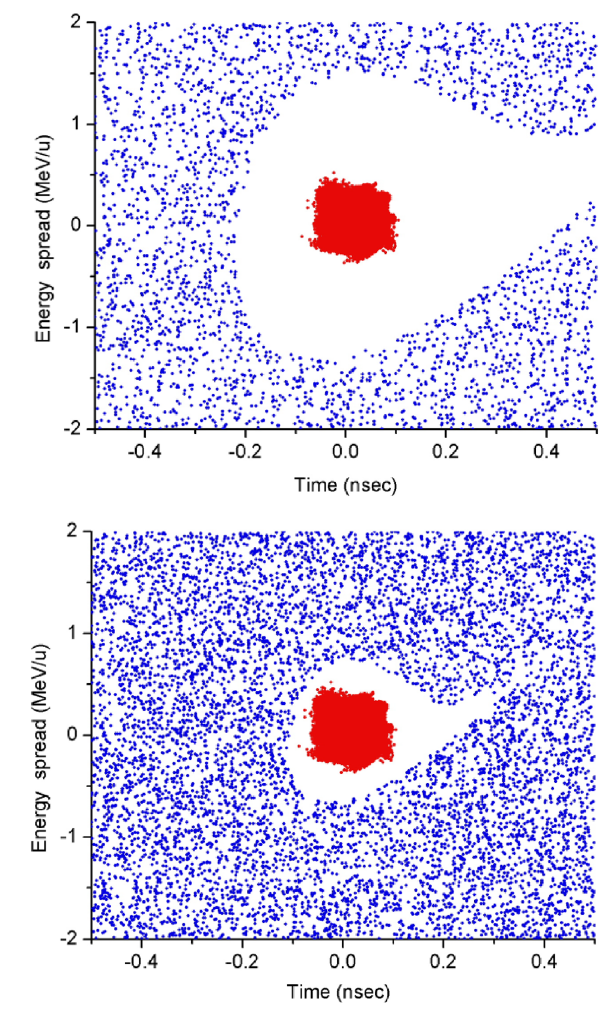
FIG. 7. (Color) Longitudinal phase space at the entrance to the high-energy section. A four-charge-state uranium beam is shown in red, superimposed on a scatter plot (blue) showing the longitudinal